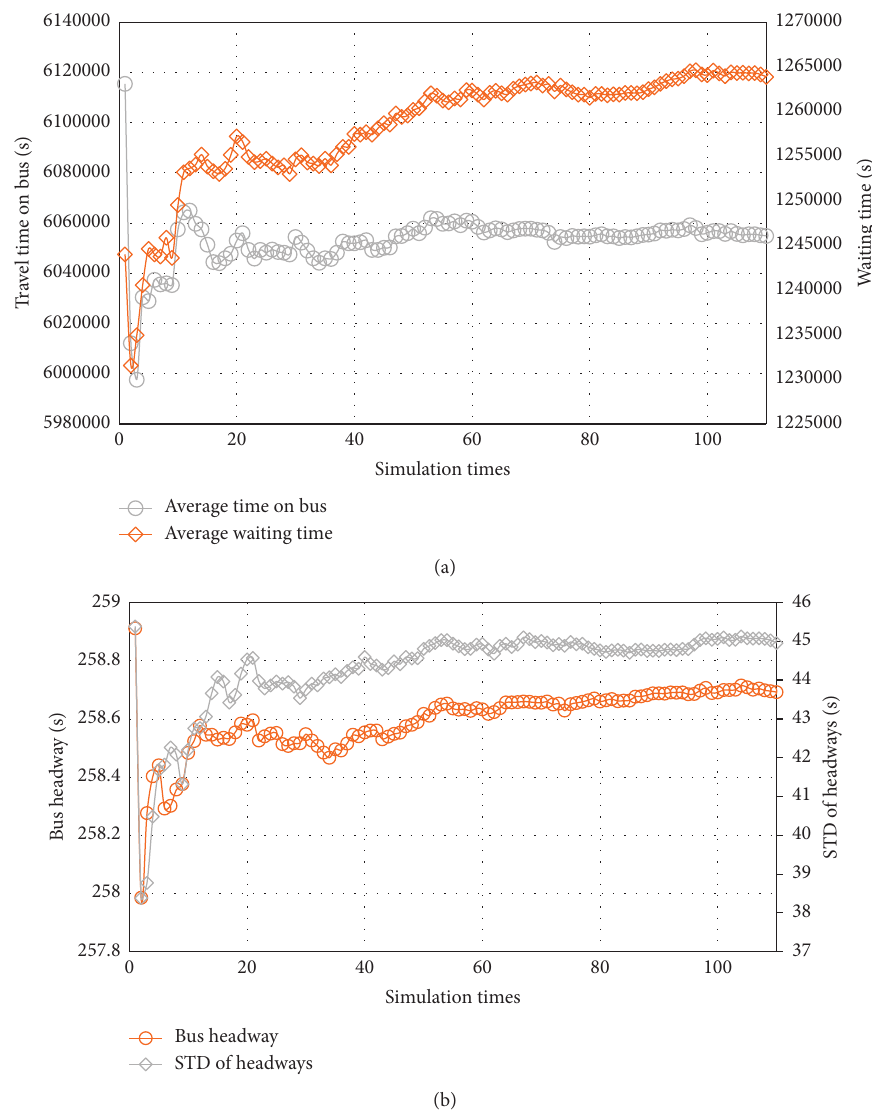
Figure 5: The convergent tendency with increasing of simulation times. (a) Travel time on bus and waiting time at bus stops. (b) Bus headways and STD of bus headways. Table 1: Bus stops selected for stop-skipping. Group Location of